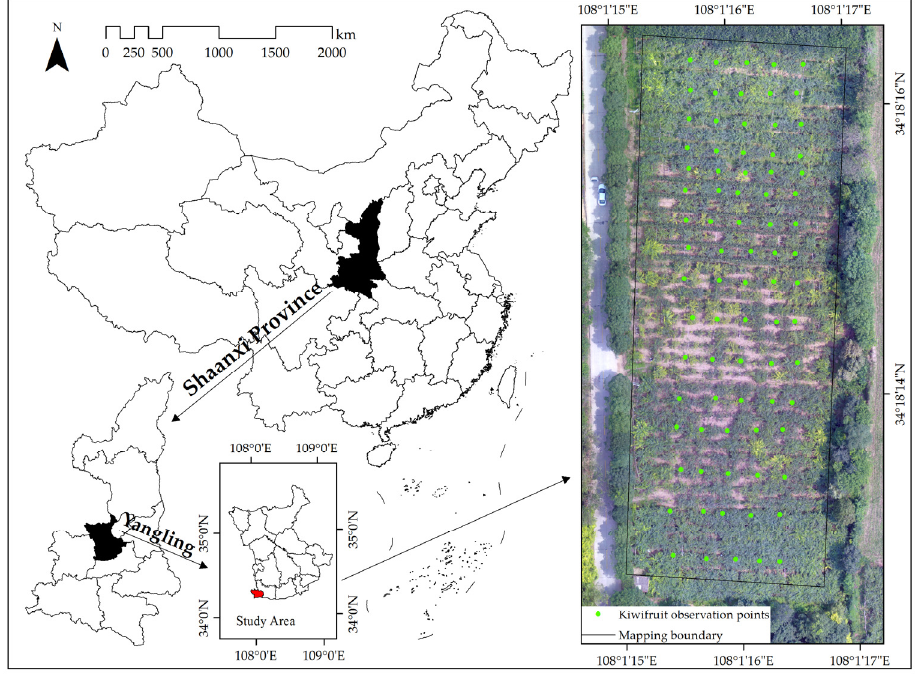
Figure 1. Geographic location and observation points of the study area.